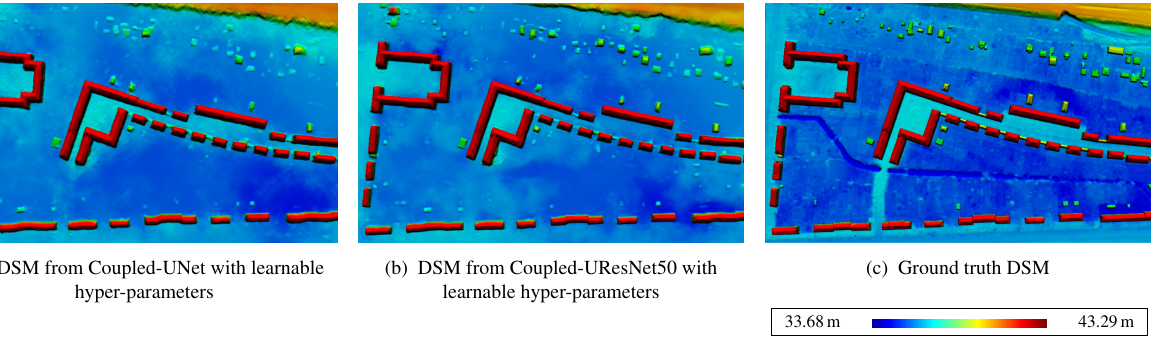
Figure 3. Visual analysis of DSMs, generated by (a) Coupled-UNet cLSGAN with fixed balancing hyper-parameters (Bittner et al., 2019b) and (b) Coupled-UResNet50 cLSGAN with learnable balancing hyper-parameters in comparison to (c) referenced surface model over selected urban area (first row) and the zoomed version of highlighted area for corresponding models (second row). DSM images are color-shaded for better visualization.